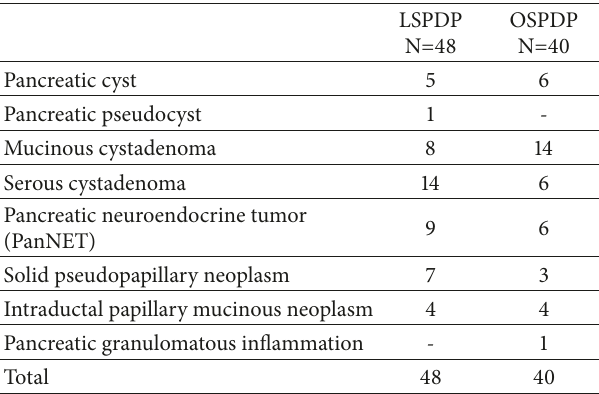
Table 2: Pathological